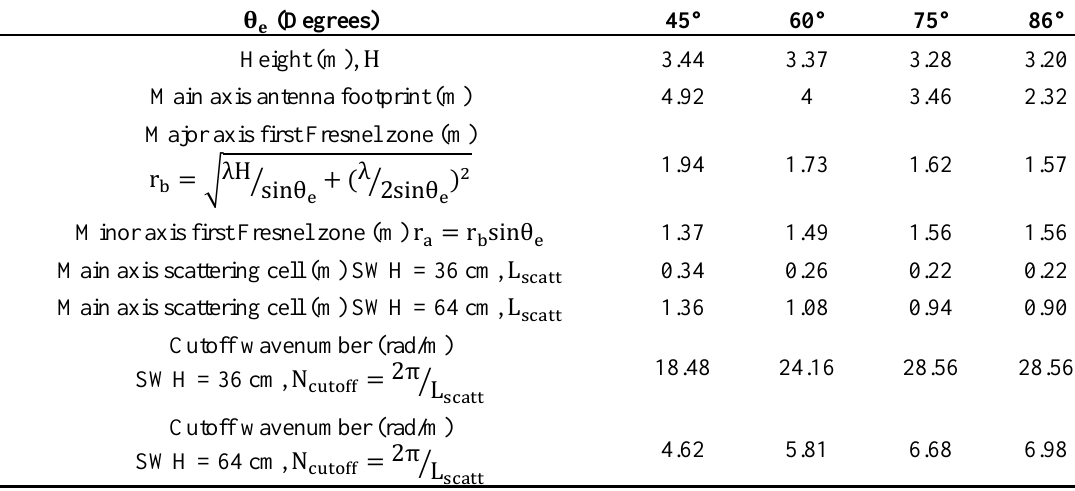
Figure 2. View of the experiment set-up: SMU 200 A vector signal generator, P(Y) and C/A ReflectOmeter (PYCARO) instrument and the two 15-dB gain antenna arrays. Table 1. Height of the antenna over the surface, sizes of the footprint, the first Fresnel zone and the scattering cells and cutoff wavenumbers as a function of the elevation angle. The antenna footprint is obtained as the intersection at different angles (elevation angles) of a plane (water surface mean) with the antenna radiation pattern. The scattering cell is obtained as the area on the water surface that allows scattering forward the GPS signals through the receiver antenna, taking into account the slopes of the waves and the surface